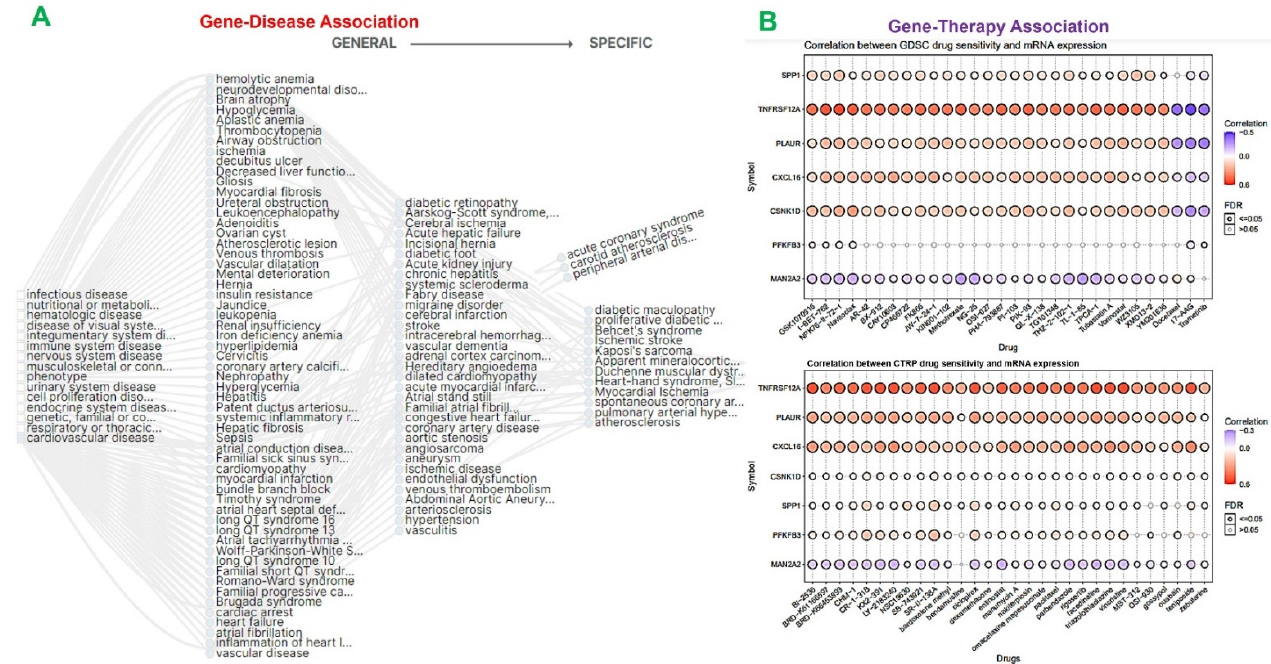
Figure 5. Gene–disease and drug sensitivity associated with the MTSCPPC signature. ( A ) Gene– disease network plot of MAN2A2, TNFRSF12A, SPP1, CSNK1D, PLAUR, PFKFB3, and CXCL16. ( B ) Bubble plot of correlations between gene mRNA expression levels and small-molecule sensitivity. Colors from blue to red represent the correlation between the 50% inhibitory concentration (IC50) value of small molecules and mRNA expression levels of the MTSCPPC signature.